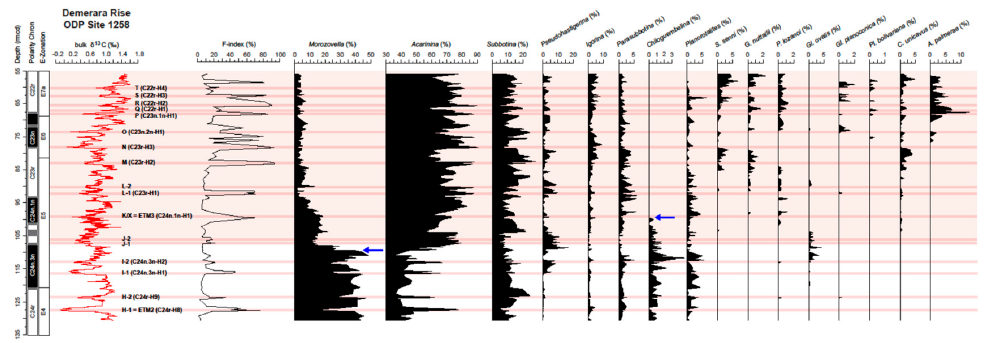
Figure 3. Bulk sediment stable carbon isotope data plotted versus the F-index and the relative abundances of planktic foraminiferal genera and species across the early Eocene interval at ODP Site 1258. Note (1) the major switch in Morozovella abundance slightly below the J event (blue arrow) and (2) the virtual disappearance of chiloguembelinids below the K/X event (blue arrow). Other information is consistent with Figure 2.